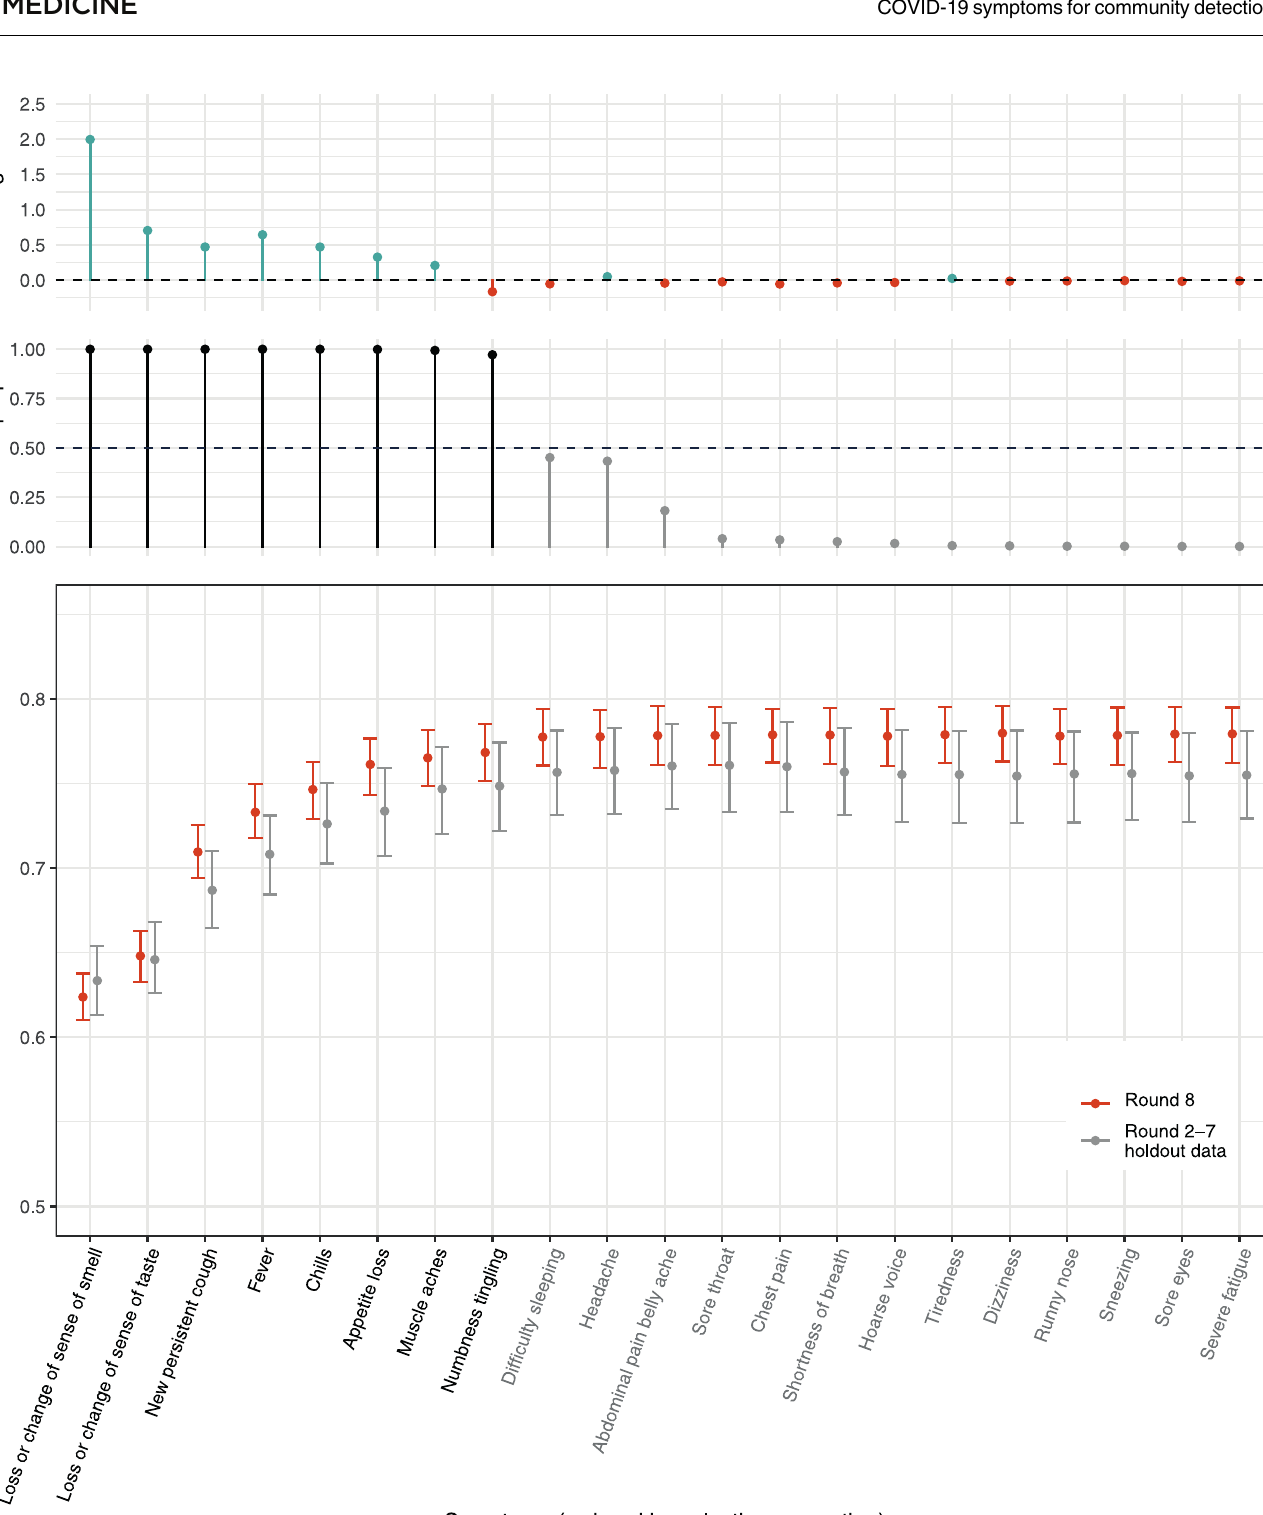
Fig 3. Selected symptoms predictive of COVID-19. Results of LASSO stability selection using 1,000 models (with 50% subsamples of training data from rounds 2–7). Mean (penalized) log odds ratios (log ORs) across all models are shown in the top panel. Positive regression coefficients are presented in teal, and negative in red. Only symptoms selected at least once are displayed. The selection proportions (selection prop.; proportion of 1,000 models that included each symptom) are shown in the middle panel; the horizontal dashed line shows the selection threshold of 50%. Symptoms are ordered according to their selection proportions, and selected symptoms are in black. The bottom panel shows the area under the curve (AUC) of models adding each variable in order of selection proportion (from left to right) in both holdout data from rounds 2–7 (grey) and data from round 8 (red).